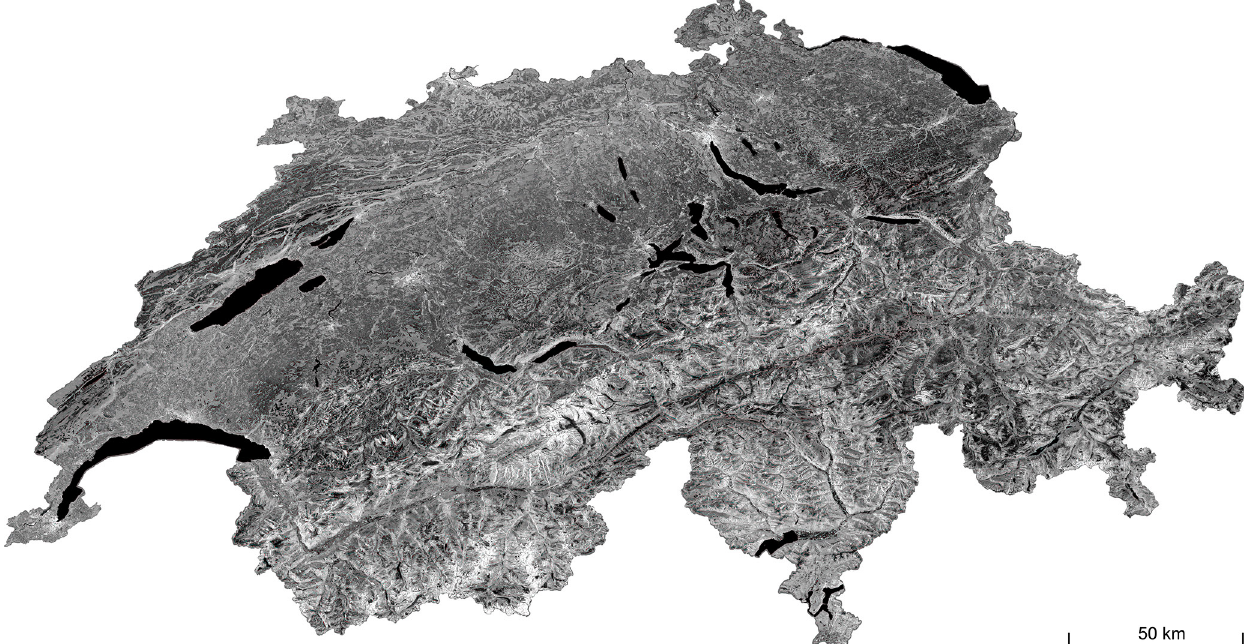
Figure 7. In the 15m resolution multiorbital S1 change detection mosaic, covering all of Switzerland for the first avalanche period around 4 January, we manually counted 7361 new avalanches. When zooming into the image, which is available online at 15m resolution (Leinss et al., 2019), many avalanches are visible in red. The image is combined from each of the 12 acquisitions from 28 December 2017 until 1 January 2018 and from 9 to 12 January 2018. All Copernicus Sentinel scenes (2019) were orthorectified with the swissALTI3D © 2019 swisstopo (JD100042), reproduced with the authorization of swisstopo (JA100120).